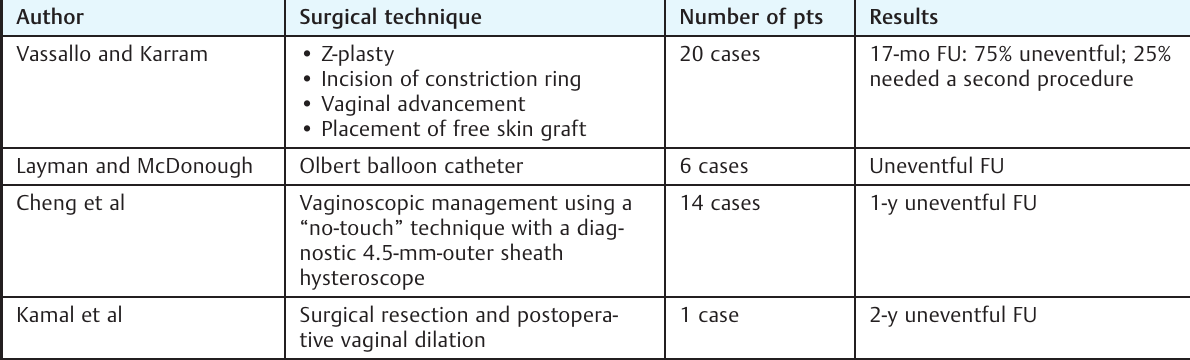
Table 1 Different techniques used for acquired vaginal stenosis Author Surgical